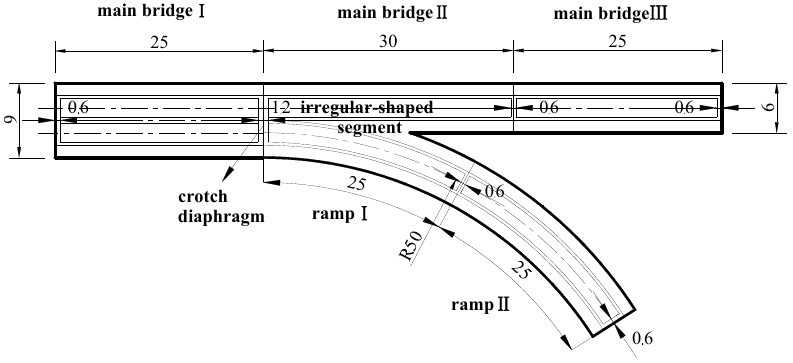
Figure 2. Plan view of the typical irregularly-shaped bridge (unit:m).